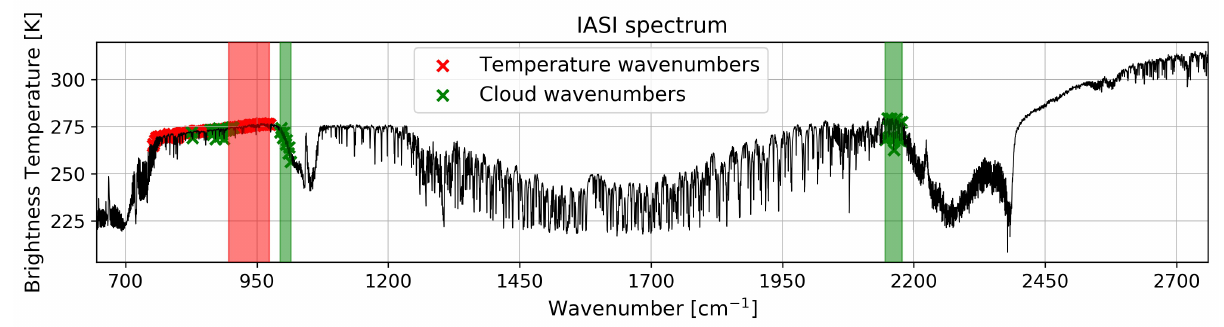
Figure 2. Location of wavenumbers related to temperature and clouds on an IASI spectrum (colored crosses). The selected wavenumbers are those inside the colored bands (red for temperature, green for clouds). The total water vapor product cannot be shown as it is calculated by a specific algorithm on the total